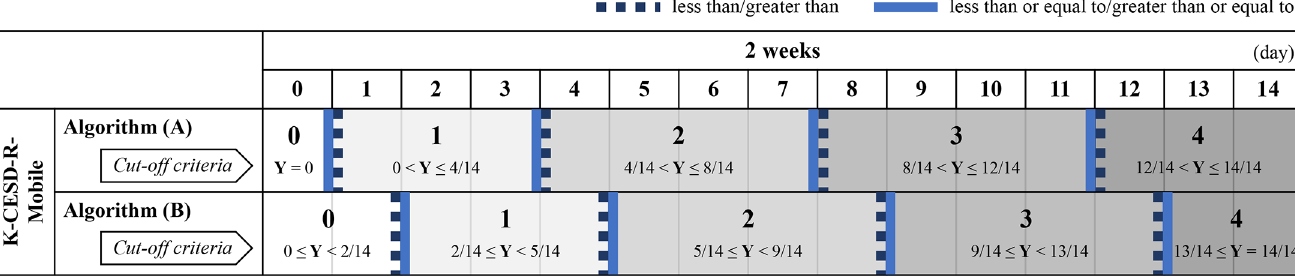
PLOS ONE | https://doi.org/10.1371/journal.pone.0199118 June 26,